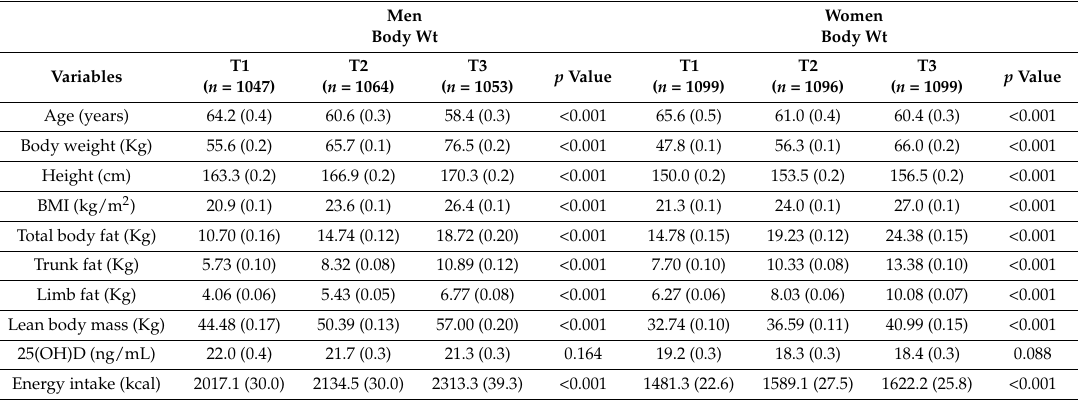
Table 3. Comparison of variables by body weight tertile in both genders.